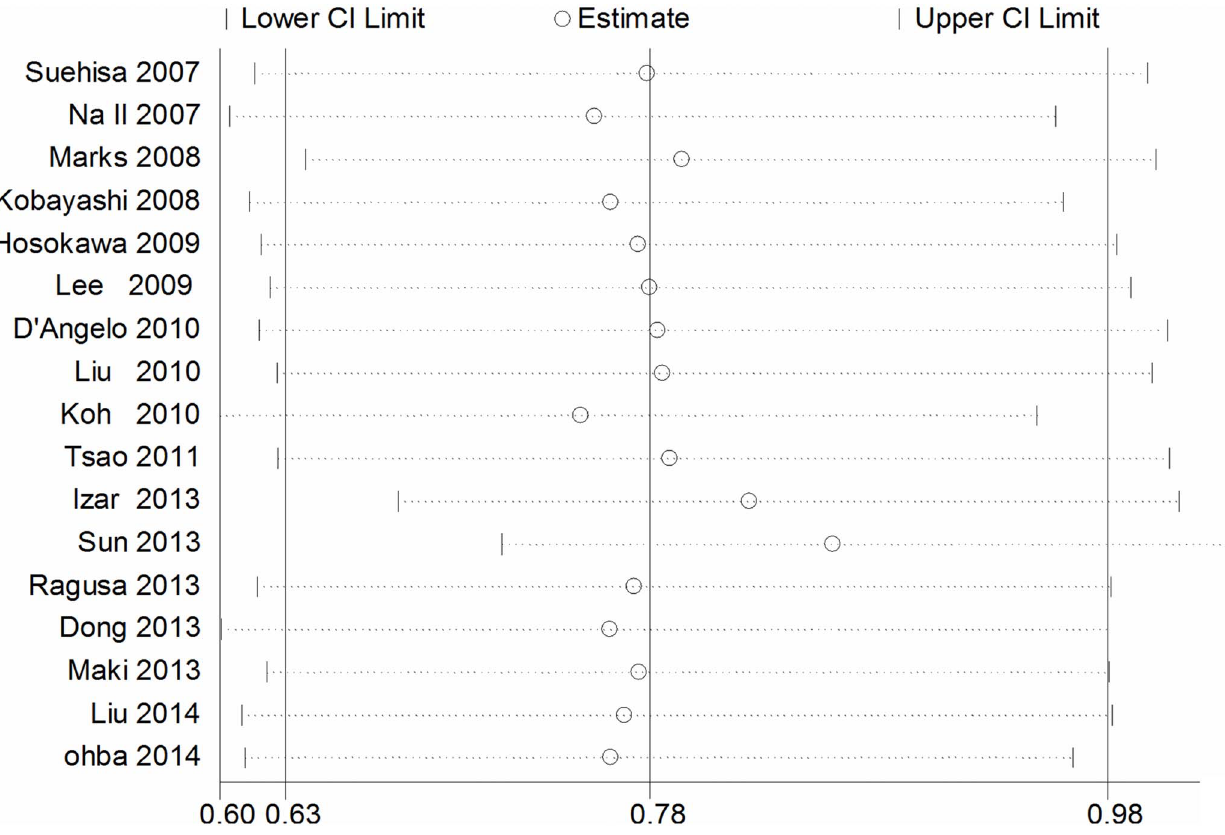
Figure 6. Sensitivity analysis for combined HRs evaluating EGFR mutations on overall survival.